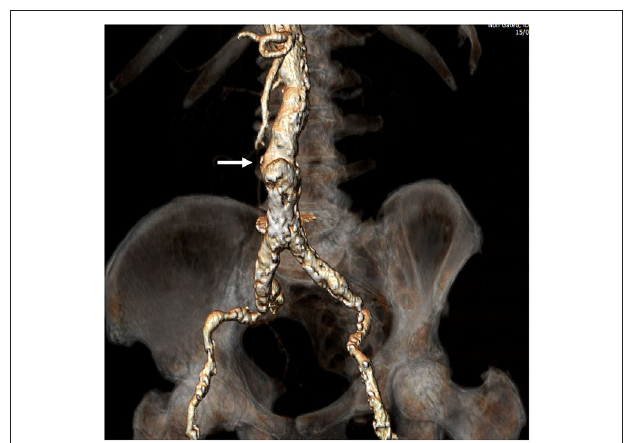
FIGURE 1 | Preprocedural computed tomography angiography. Full evaluation of bilateral ilio-femoral arteries was performed assessing for minimal vessel diameter, extent and circumference of calcification, and vessel tortuosity. Once a patient was deemed as high-risk for standard trans-femoral access as shown in the figure, a calcium-free window in the infra-renal abdominal aorta was identified. This would be the target for traversal from the vena cava to the abdominal aorta